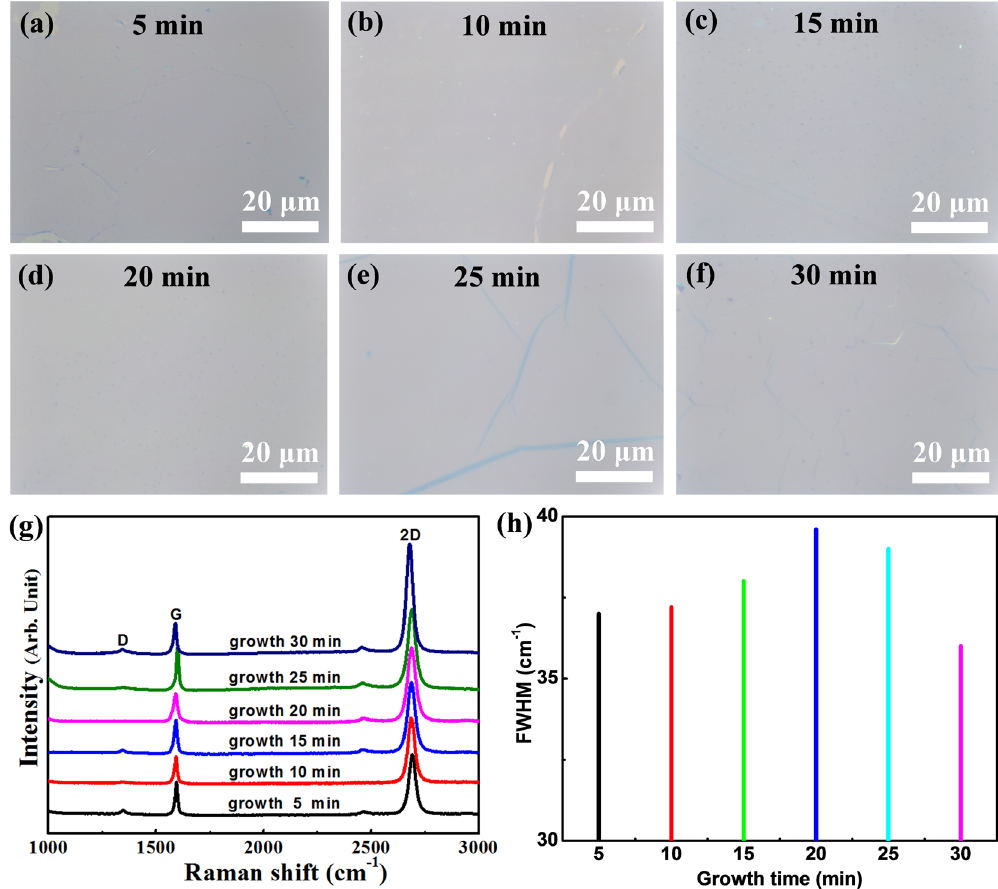
Figure 5. ( a – f ) Optical images of graphene on h-BN, for growth times of 5, 10, 15, 20, 25, and 30 min, respectively. ( g ) Raman spectra and ( h ) FWHM of the 2D band of graphene on h-BN, for growth times of 5, 10, 15, 20, 25, and 30